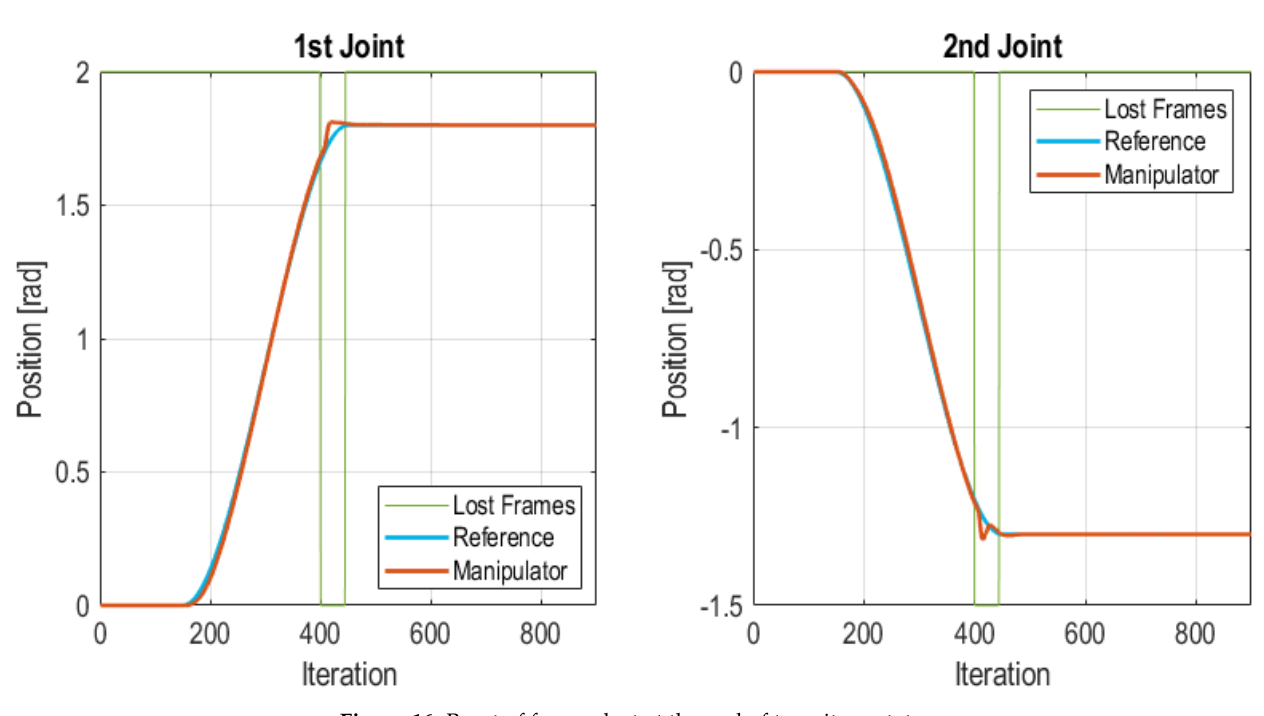
Figure 16. Burst of frames lost at the end of transitory state.